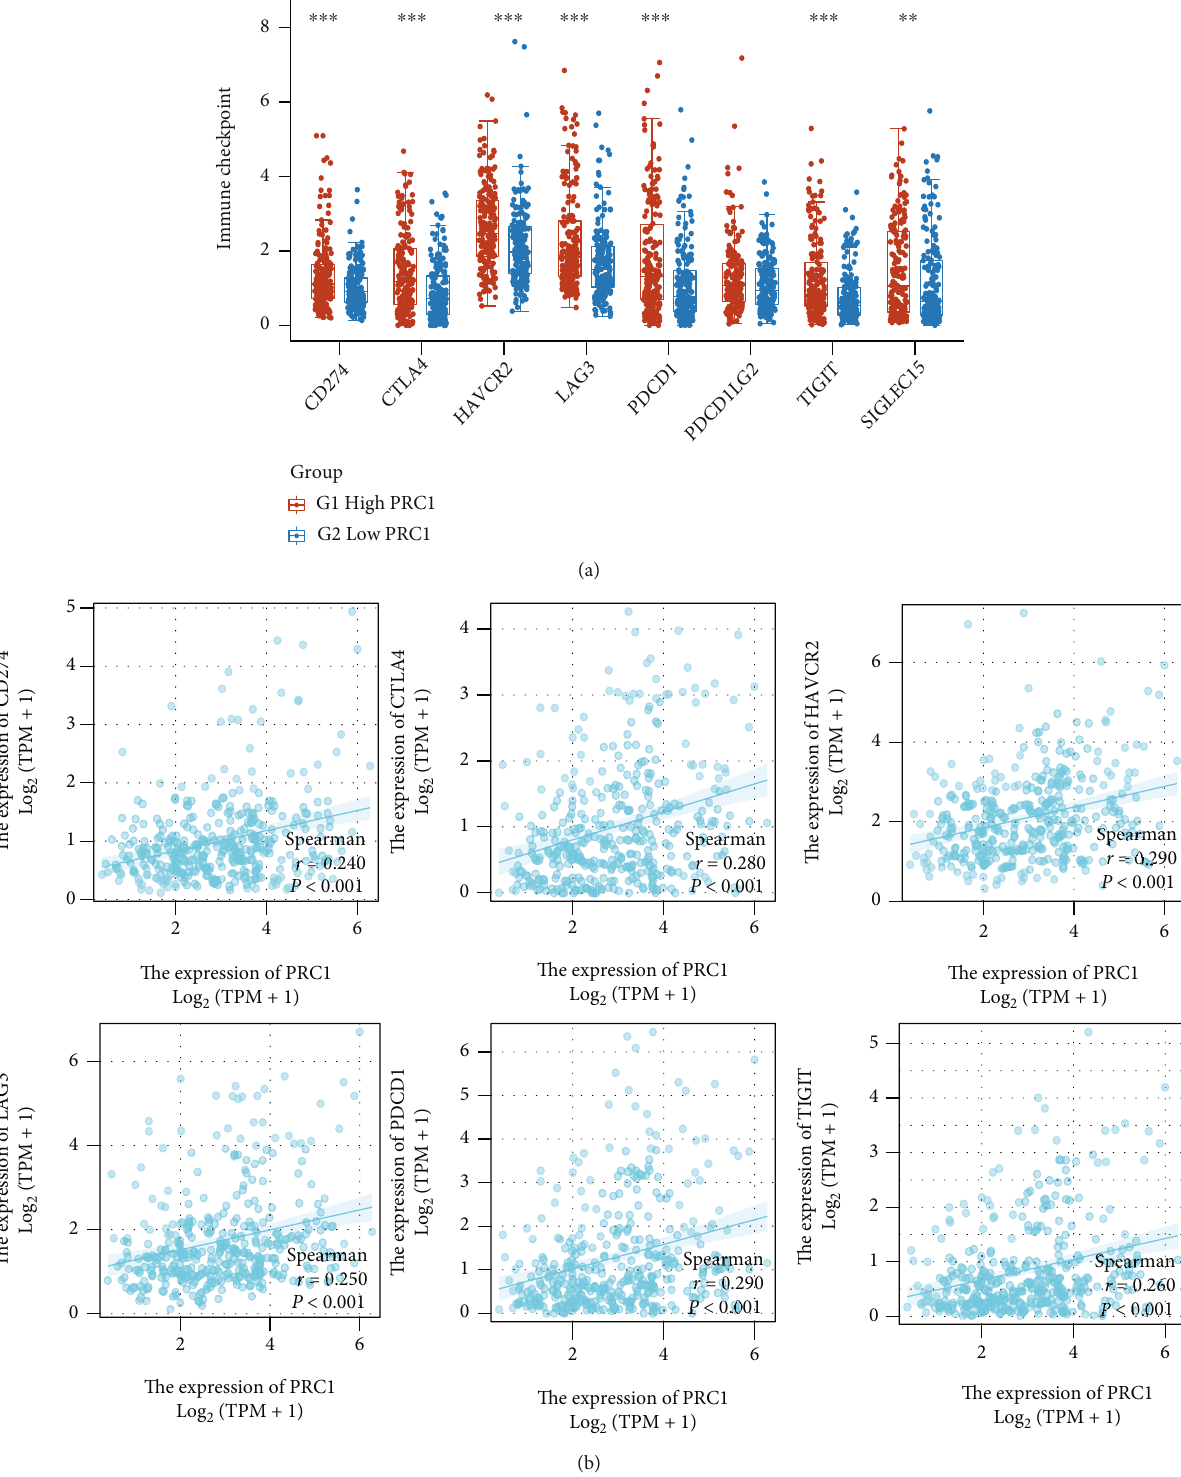
Figure 10: Correlation of PRC1 expression with immune checkpoint molecules. (a) The expressions of immune checkpoint molecules were signi fi cantly higher in the LIHC group with high PRC1 expression. (b) The expressions of immune checkpoint molecules were signi fi cantly associated with PRC1. ∗∗ p < 0 : 01 ; ∗∗∗ p < 0 : 001